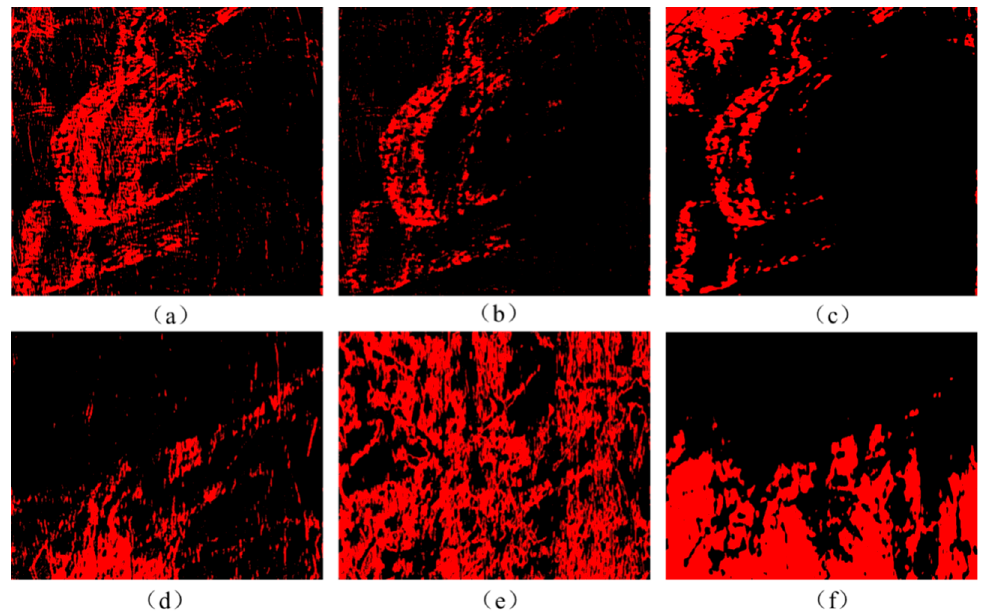
Figure 12. The extraction results of the hidden information of area 1 with different methods. ( a ) Result of the proposed method; ( b ) result of the Spectral Angle Mapper (SAM); ( c ) result of the Support Vector Machine (SVM); extraction results of the hidden information of area 2 with different methods; ( d ) result of the proposed method; ( e ) result of the SAM; ( f ) result of the SVM.